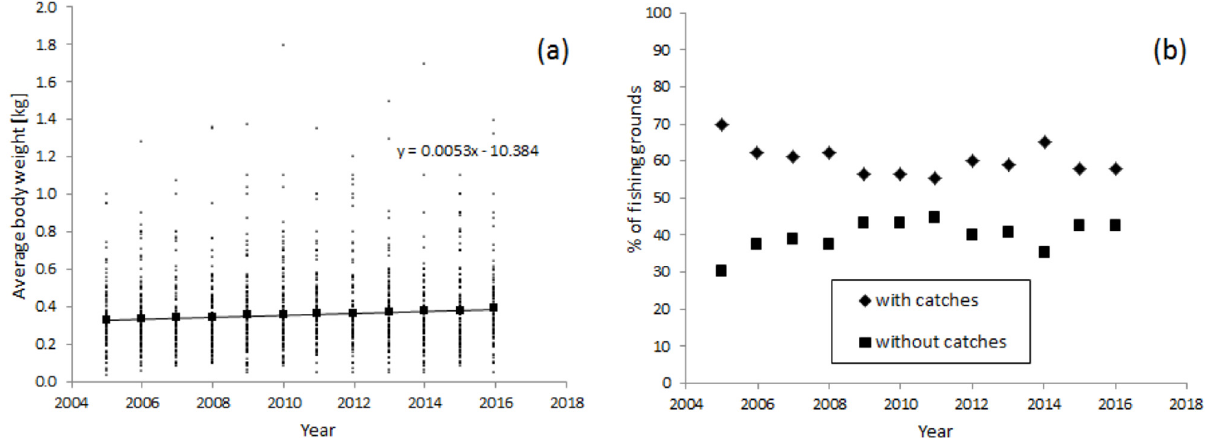
Fig. 4. Average body weight (a) of perch in catches of recreational anglers and percentage of fi shing grounds with and without perch catches Table 4. Results of GLMM models for recreational annual catches of perch Perca fl uviatilis on different fi shing grounds. Dependent variable